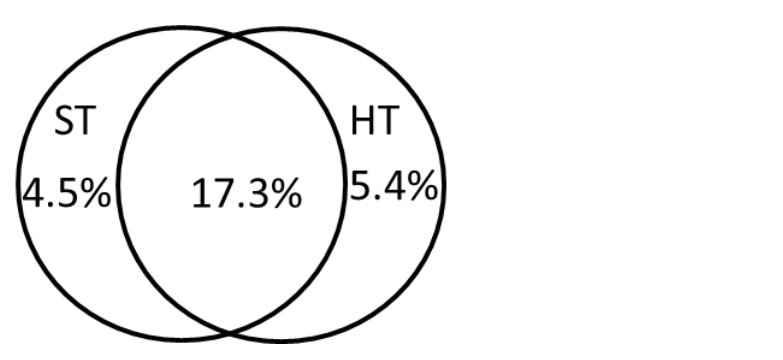
Figure 2. Partitioning of the variance in invasive species data into the contributions of two subsets of environmental variables, which denote soil types (ST) and habitat types (HT) and shared portion by these two groups.